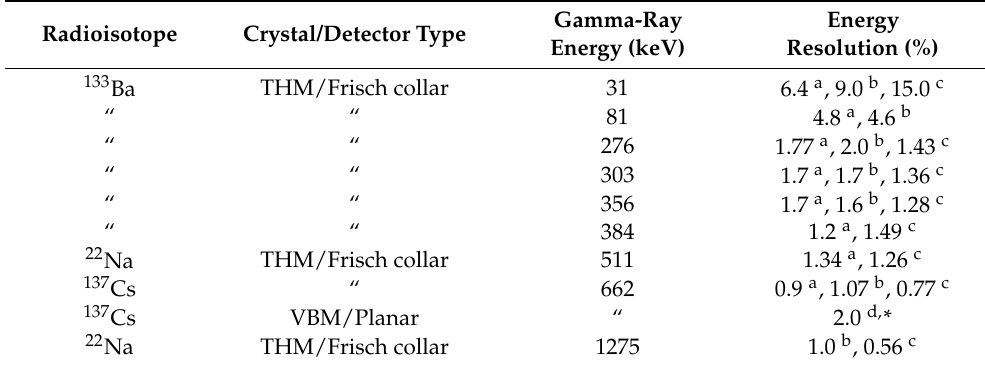
Table 1. Reported values of energy resolution obtained using THM and VBM grown CZTS detectors in different geometries.